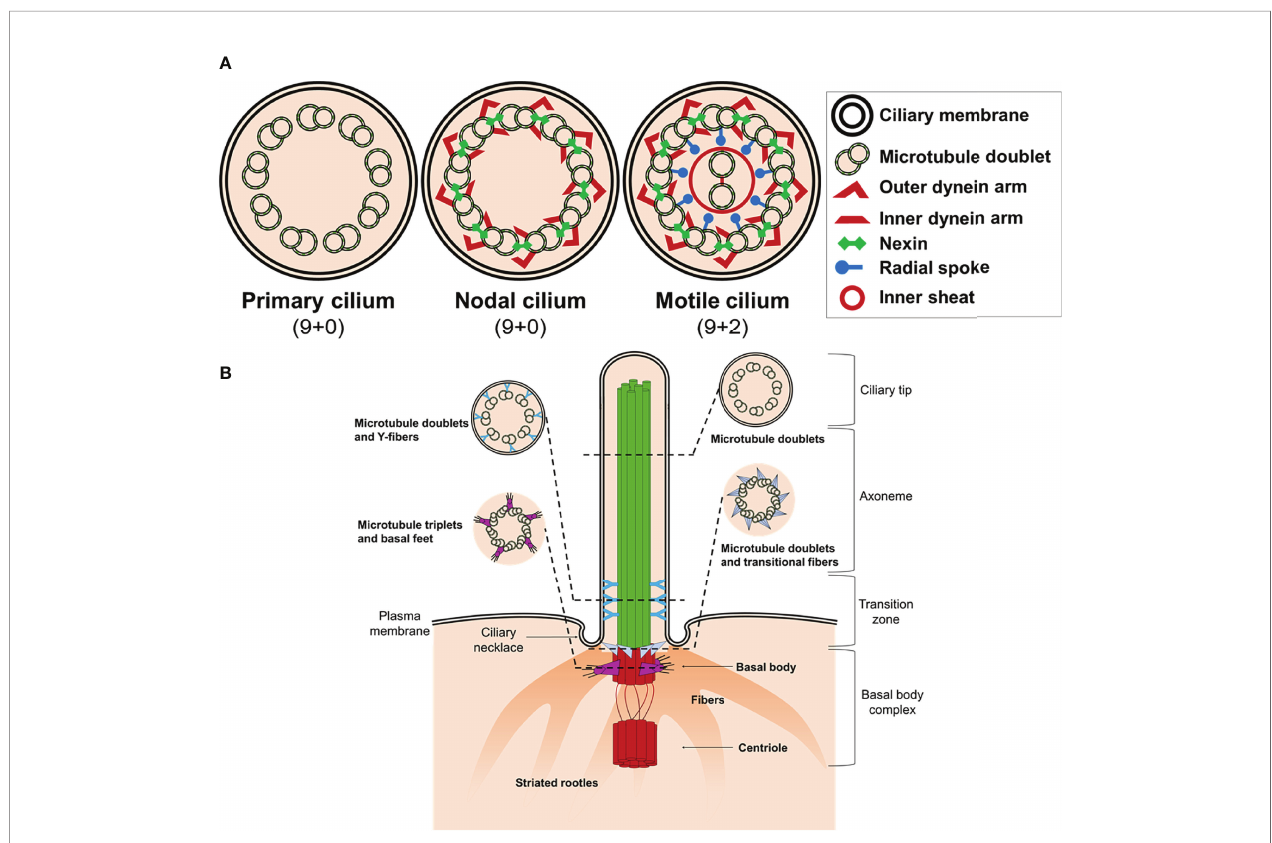
FIGURE 1 | Structure of cilium. (A) Schematic representation of an axoneme cross section from a primary cilium, nodal cilium, and motile cilium. The axoneme cilium is composed of nine outer doublets of microtubules surrounding a central pair (9 + 2). The axoneme is ensheathed by a ciliary membrane. Inner and outer dynein arms, nexin, and radial spokes are responsible to link microtubules and form a cylindrical structure. (B) Schematic diagram of a typical non-motile primary cilium. The primary cilium is divided into the ciliary tip, the membrane bound axoneme extending from surface, the transition zone, and the basal body complex. The ciliary tip ends contain signaling molecules and can undergo morphological changes in response to signaling processes. The axoneme is the structural core of a cilium. The transition zone converts the triplet microtubular structure of the basal body into the axonemal doublet structure. The ciliary pocket (necklace) is an invagination of the plasma membrane at the root of cilium. The basal body complex comprises the basal body and its centriole. In most quiescent cells, the centrioles move to the apical plasma membrane and the basal body (mother centriole) functions as the microtubule-organizing centre to nucleate the axonemal microtubules. The centriole (daughter centriole) remains perpendicular to the basal